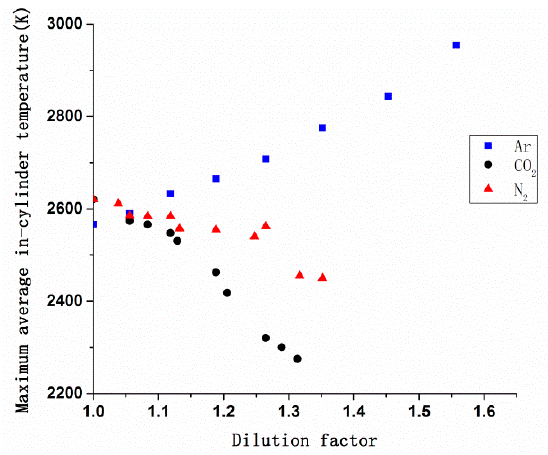
Figure 6. Variation in the maximum average in-cylinder temperature vs. the DF of CO 2 , N 2 , and Ar.